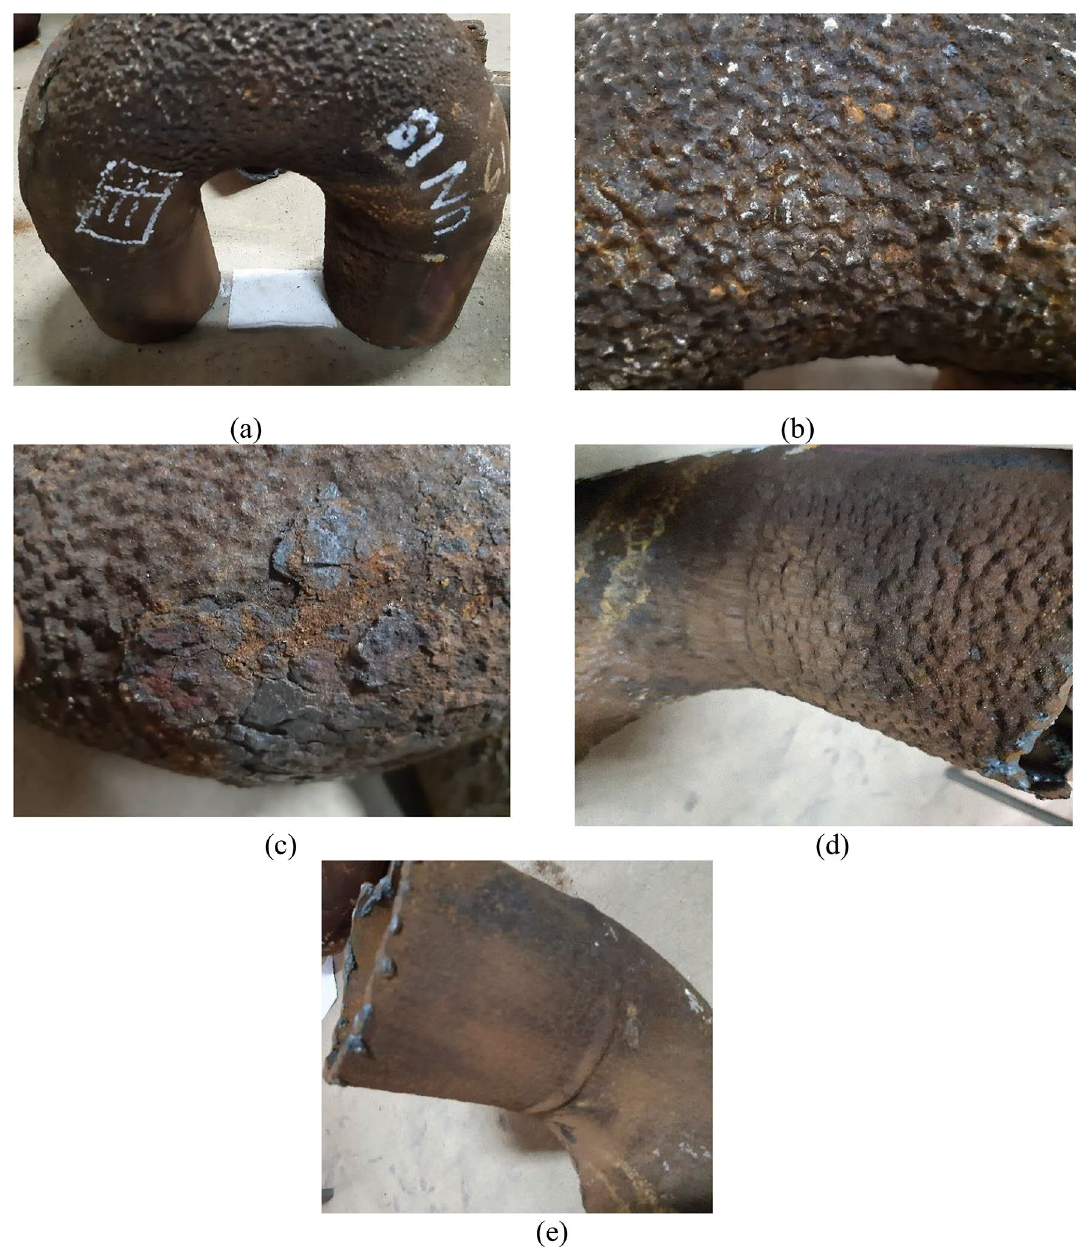
Figure 7. Images of the damaged elbow UN19. (a) general views, (b) coarse and shallow pits, (c) flaky and coarse gained rust layers, might indicate the increased chloride contamination in the rust, (d) lower leg covered with deposits, and (e) upper leg not covered with deposits. The elbow was at the convection section of the heater on the north side, and the U bend was facing the north direction, which is the dominant direction of marine and coastal winds. Corrosion damage occurred at the U bend, and the elbow leg was covered with deposits and sediments in service. The damage is coarse and shallow